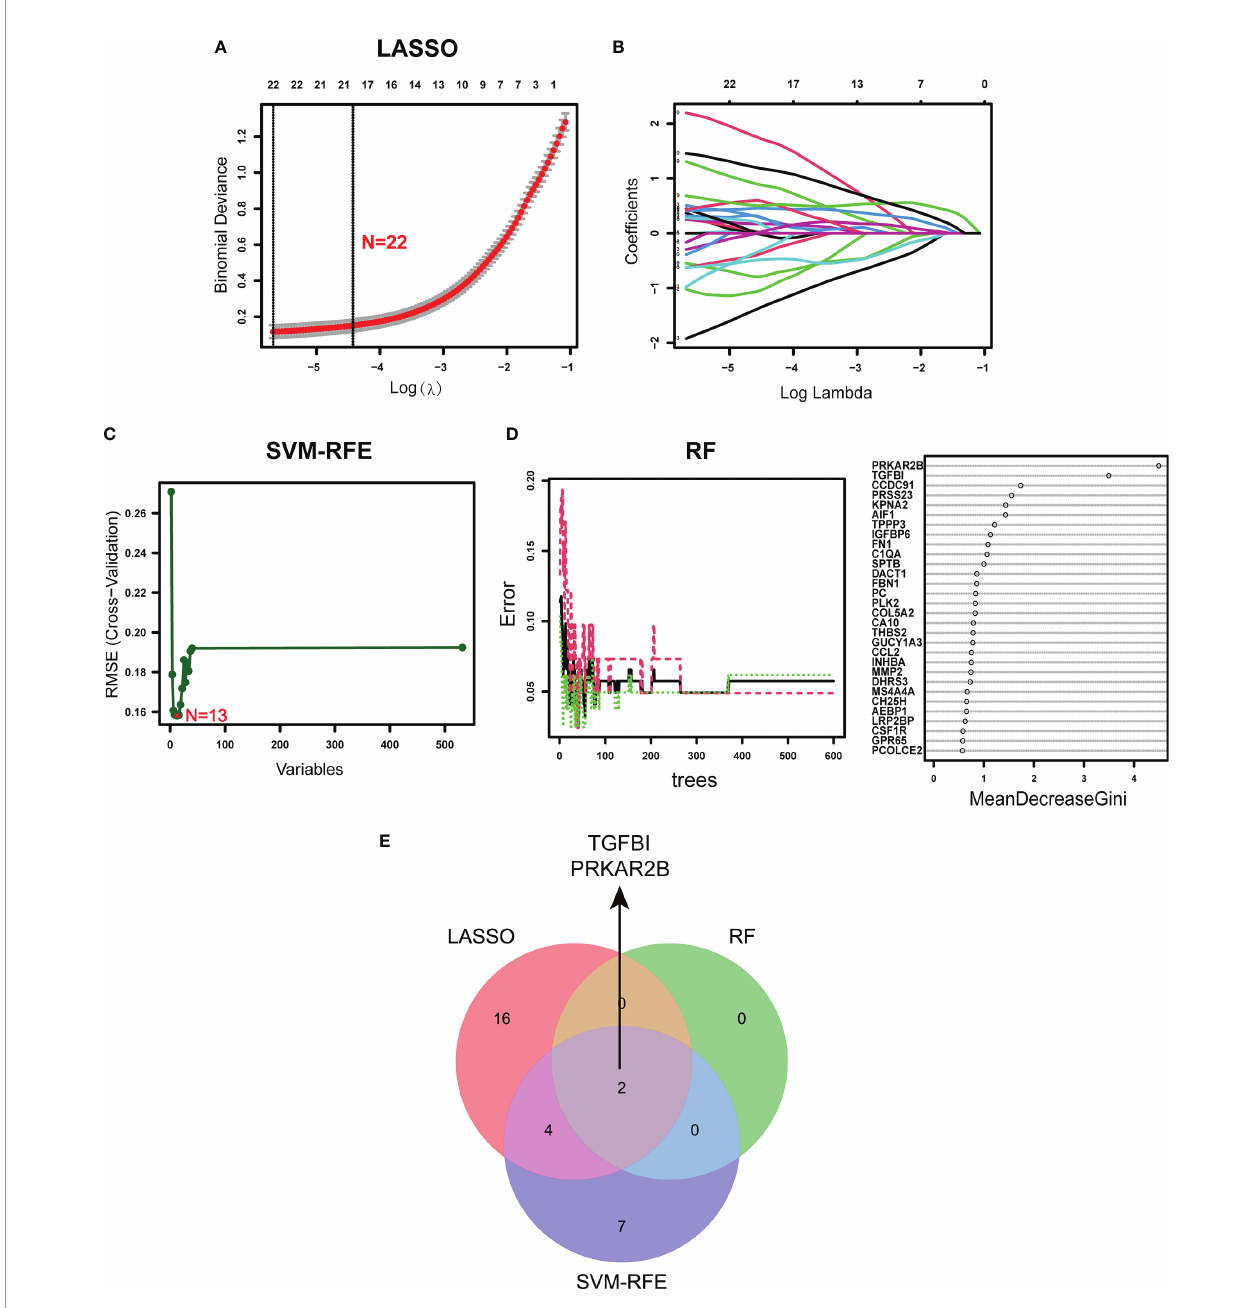
FIGURE 3 | Identi fi cation of the diagnostic biomarkers from the selected modules. (A, B) LASSO regression analysis. (C) SVM-RFE algorithm. (D) RF algorithm. (E) Venn plot exhibiting the reliable biomarkers among LASSO, SVM-RFE, and